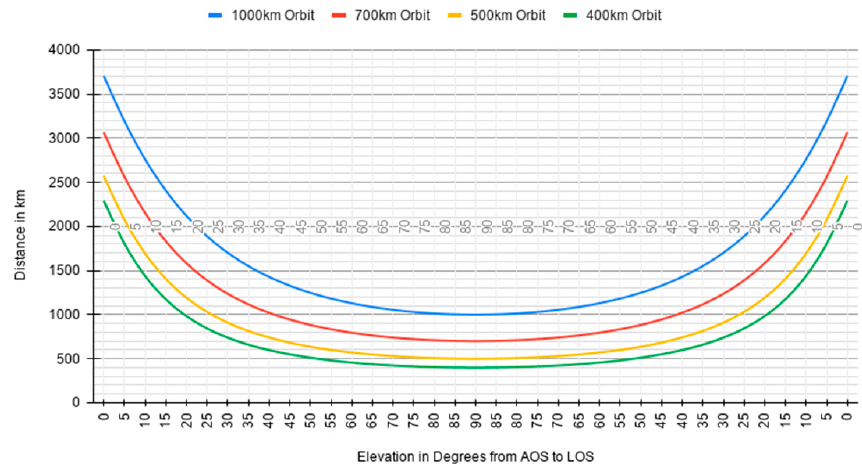
Figure 2. Slant range vs. elevation of different orbits.